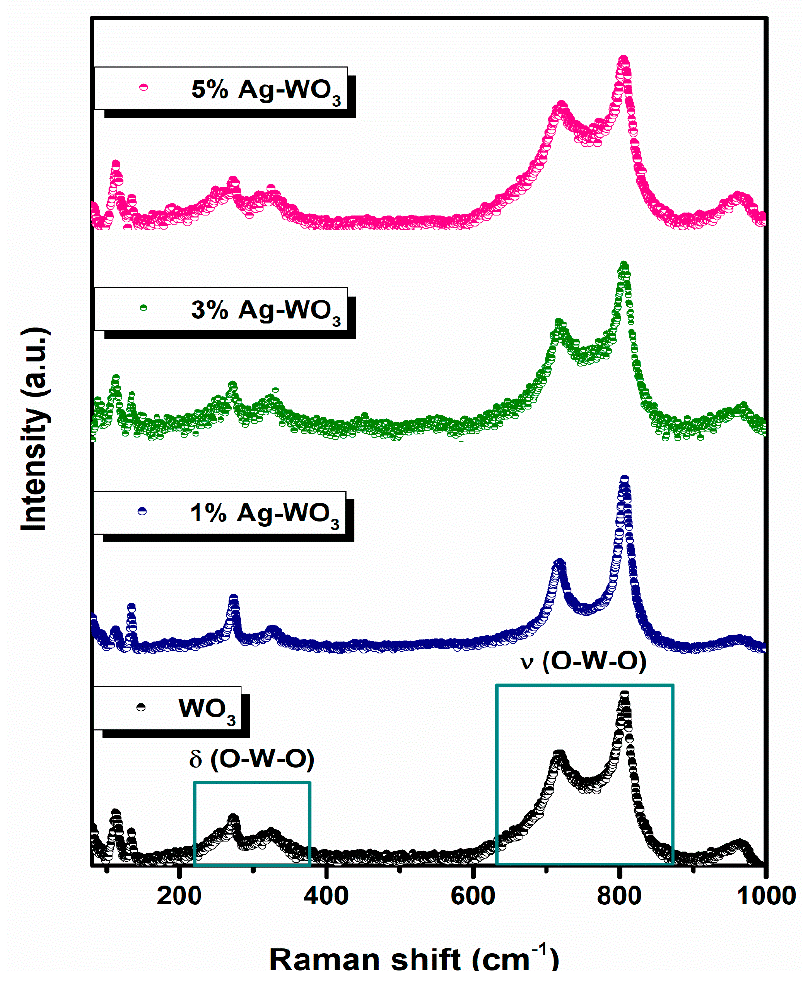
Figure 3. Raman spectra of Ag–WO 3 films.